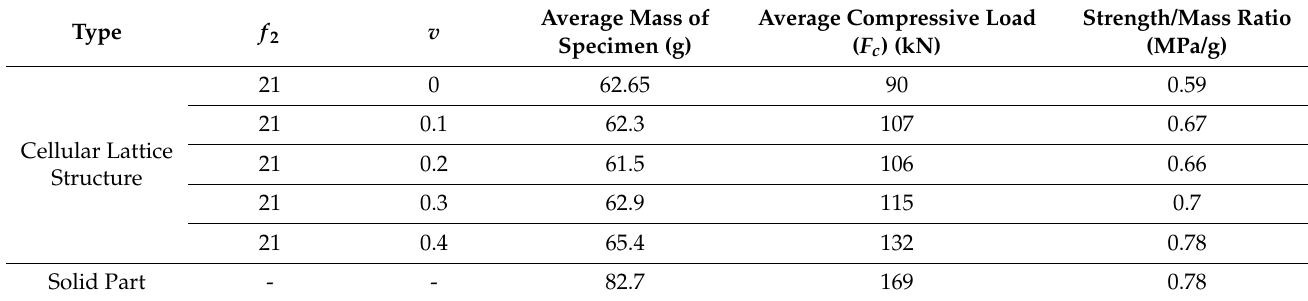
Table 7. First test series results of test specimens with frequency 21 and 100% infill density.